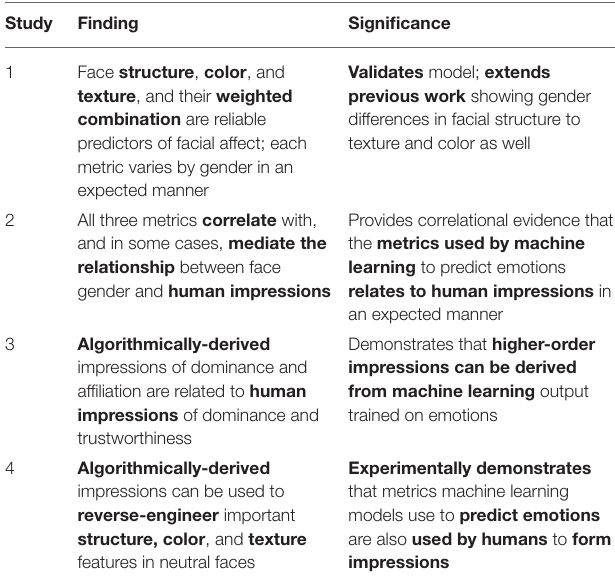
TABLE 4 | Summary of findings and significance across the four studies presented in the current